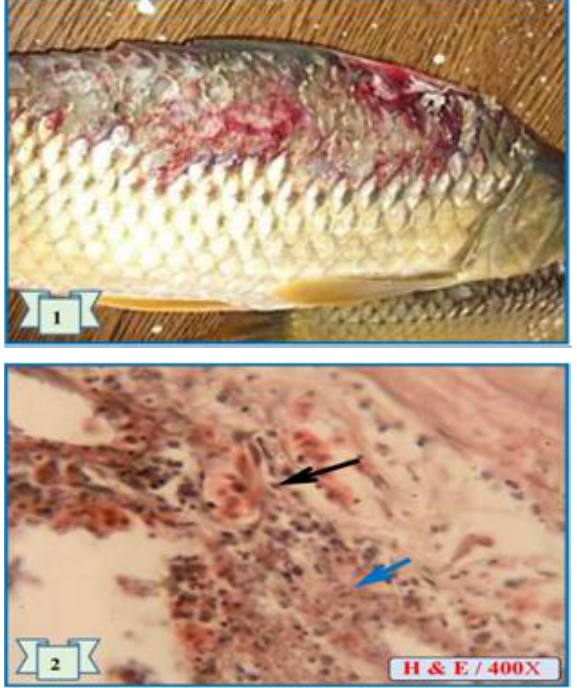
Figure, 7: Hemorrhagic septicemia in common carp. Grossly [1] there is ulcerative lesions surrounded by hemorrhagic area (arrow). Microscopically [2] there is hemorrhage (arrow) and necrosis (arrow) in intestines.